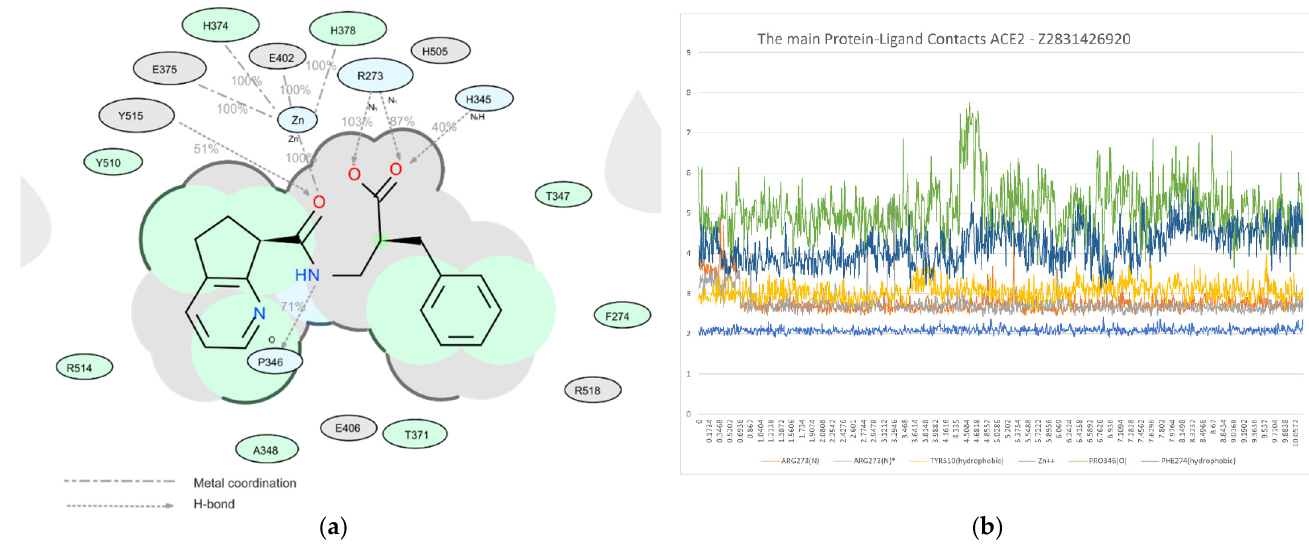
Figure 11. A detailed interaction scheme of ligand atoms (Z2831426920) with protein residues: ( a ) generalized graphical representation of the interactions and contacts (H-bonds, hydrophobic, ionic, water bridges); ( b ) scheme showing the distance evolution (in Å) between the ligand and residues.